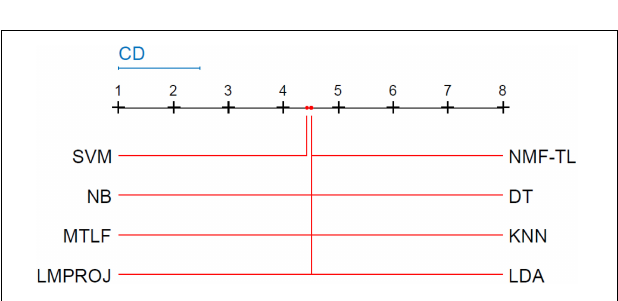
FIGURE 8 | Nemenyi test chart of 8 different methods on datasets based on SIFT feature extraction.